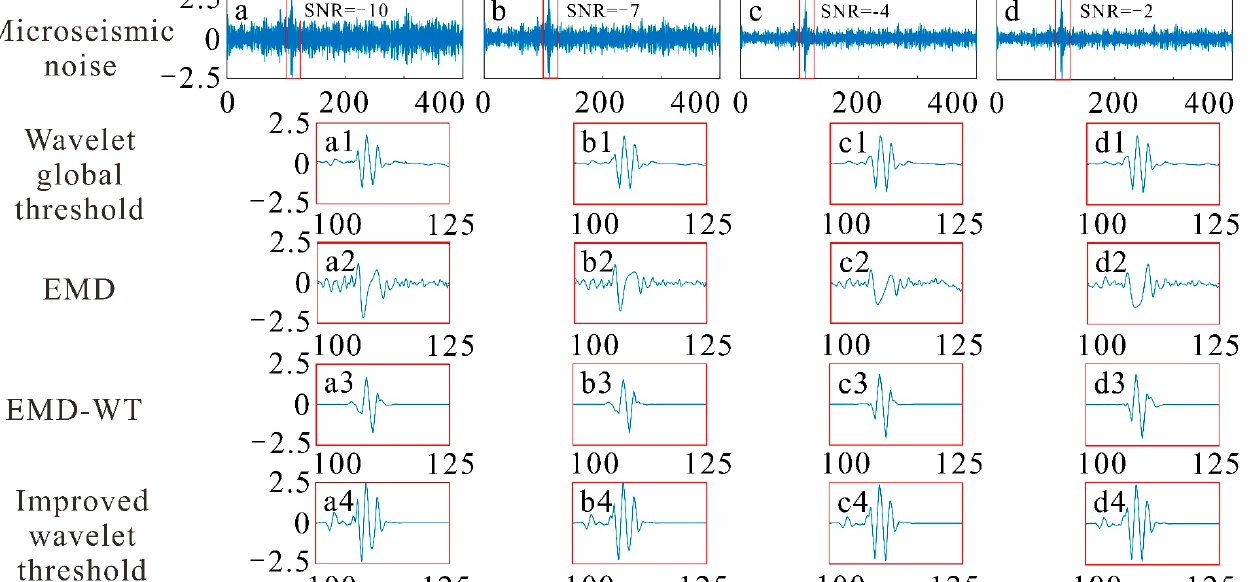
Figure 9. Comparison of the denoising of synthesized microseismic current signals with different SNRs: ( a ) microseismic current of SNR = − 10, ( b ) microseismic current of SNR = − 7, ( c ) microseismic current of SNR = − 4, ( d ) microseismic current noise of SNR = − 2, ( a1 , b1 , c1 , d1 ) Wavelet global thresh- old denoising signal, ( a2 , b2 , c2 , d2 ) EMD denoising signal, ( a3 , b3 , c3 , d3 ) EMD-WT denoising signal, ( a4 , b4 , c4 , d4 ) improved wavelet threshold denoising signal.